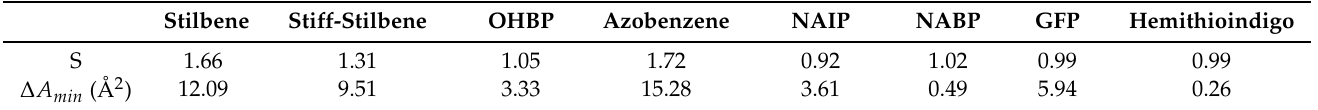
Table 3. Change of the geometry upon the cis/trans transition.